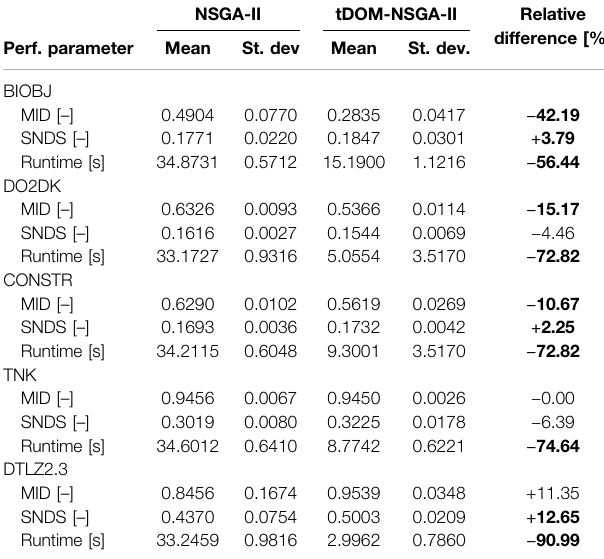
TABLE 2 | Performance parameters and runtime of the bi- and three-objective case studies, generated with the constrained NSGA-II algorithm (Constr. NSGA-II) and the developed t-DOM-NSGA-II algorithm. Relative differences marked in bold indicate that the tDOM-NSGA-II algorithm outperformed the NSGA-II